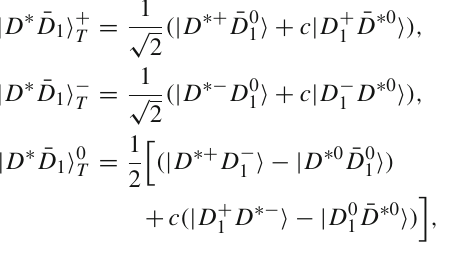
For a loosely bound system, long-range interaction by the π exchange should be more important than short-range inter- action by exchanges of heavier mesons. The Z ( 4430 ) locates ¯ D 1 threshold, so in the current work it will higher than the D ∗ be seen as a resonance state where the interaction is even weaker than a loosely bound state. Hence, the dominance